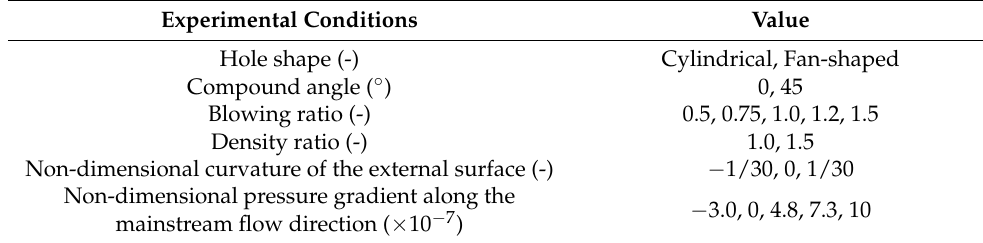
Table 1. Experimental conditions in the